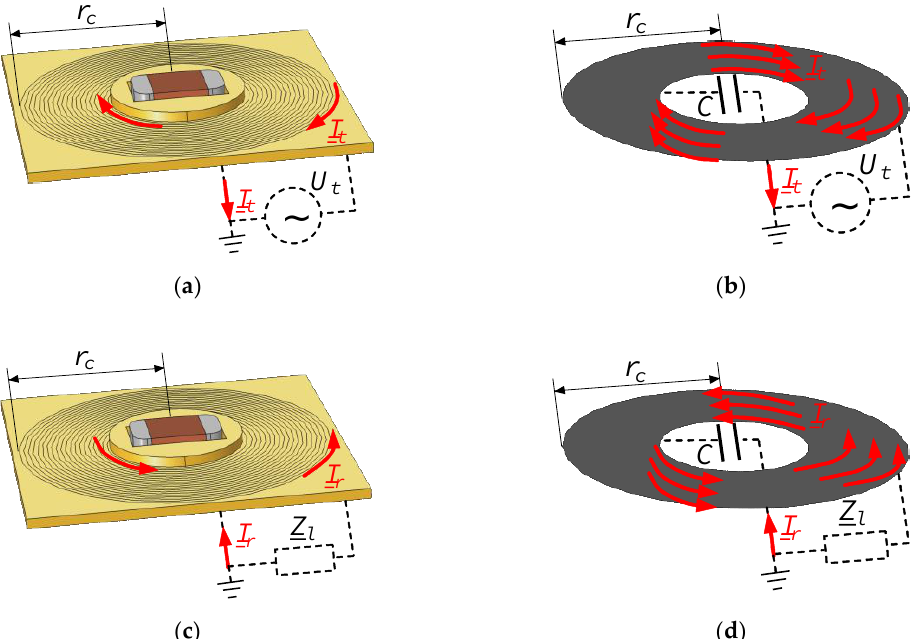
Figure 3. Models of multi-turn spiral coils: full model of ( a ) transmitting coil and ( c ) receiving coil; simplified model, using current sheet approximation method and attached electrical circuit for ( b ) transmitting coil and ( d ) receiving coil.